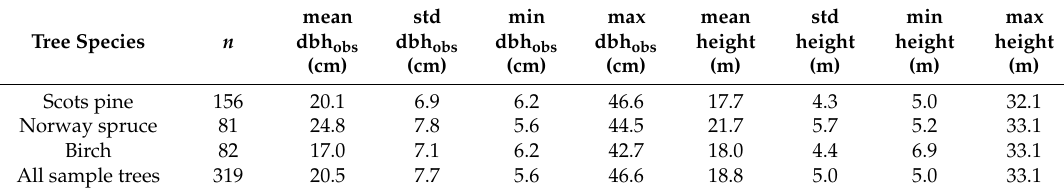
Table 1. The mean and standard deviation (std) of dbh obs (diameter-at-breast-height) and height of the sample trees as well as the variation range of dbh and height among the sample